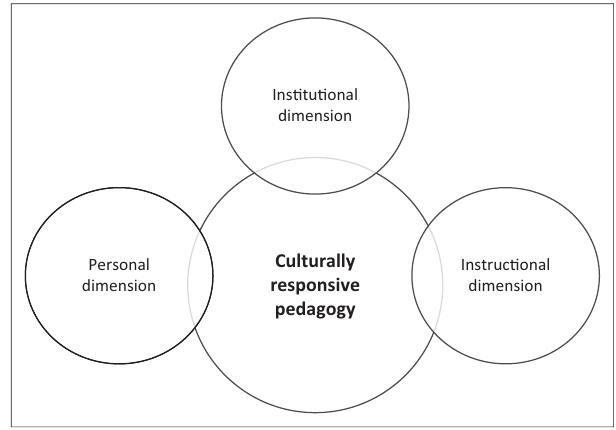
FIGURE 3: Clinical training through culturally responsive pedagogy (and